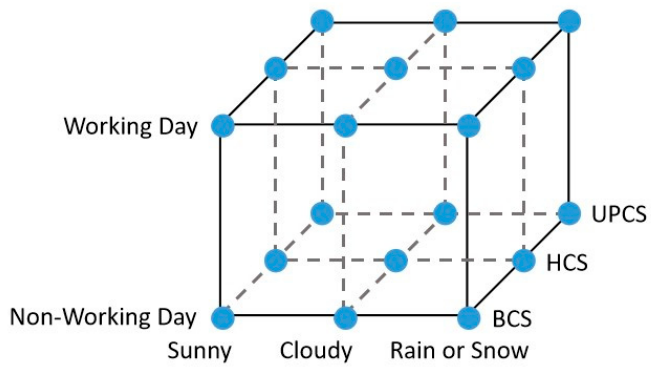
Figure 1. The division of different charging scenarios.